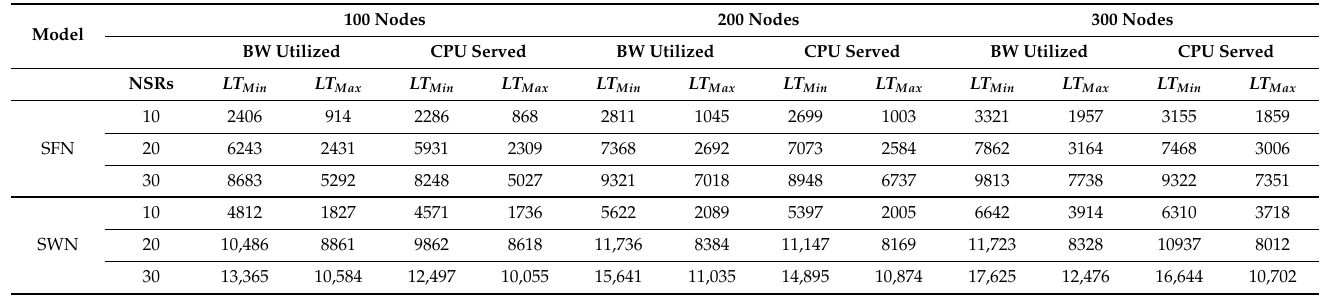
Table 5. Performance comparison with fixed LT NSR